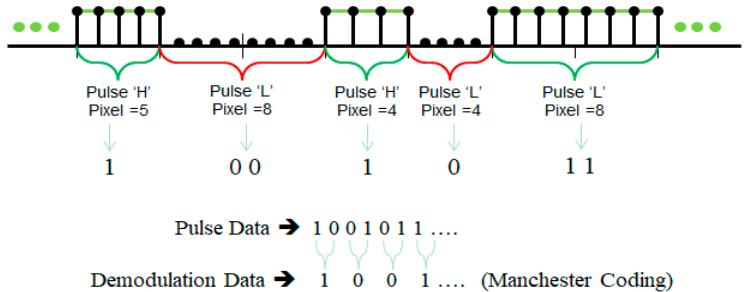
Figure 5. An example of pulse data detection from binary sequences and data modulation.